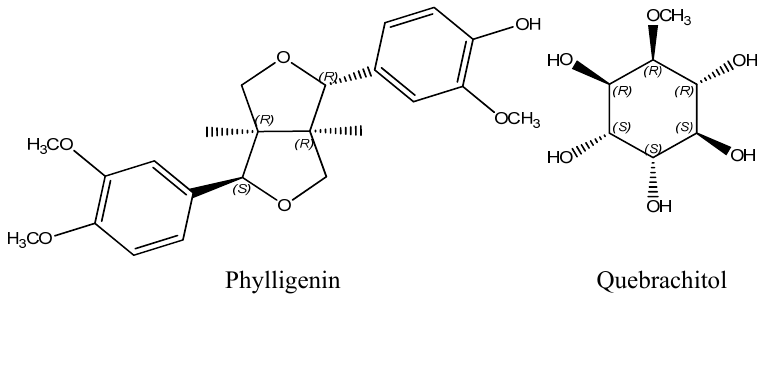
Figure 1. Structures of compounds from Mitrephora